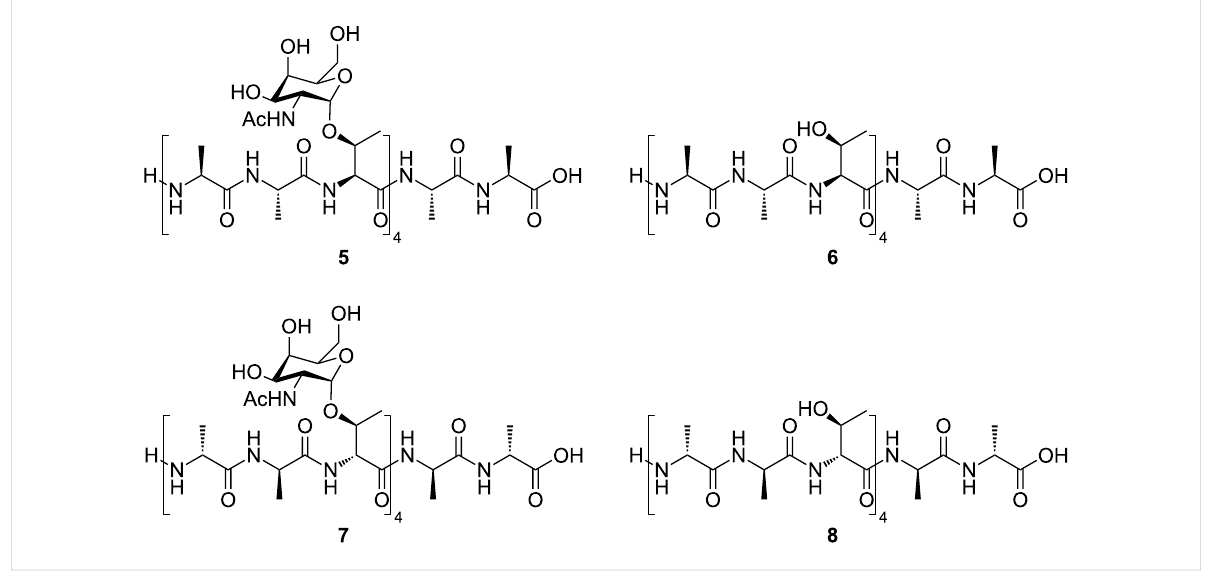
Scheme 2: Structures of monosaccharide-substituted AFGP analogues containing allo -L-threonine and L-alanine 5 , the corresponding aglycon 6 , the L-glycopeptide comprising D-threonine and D-alanine 7 , and the aglycon 8 .